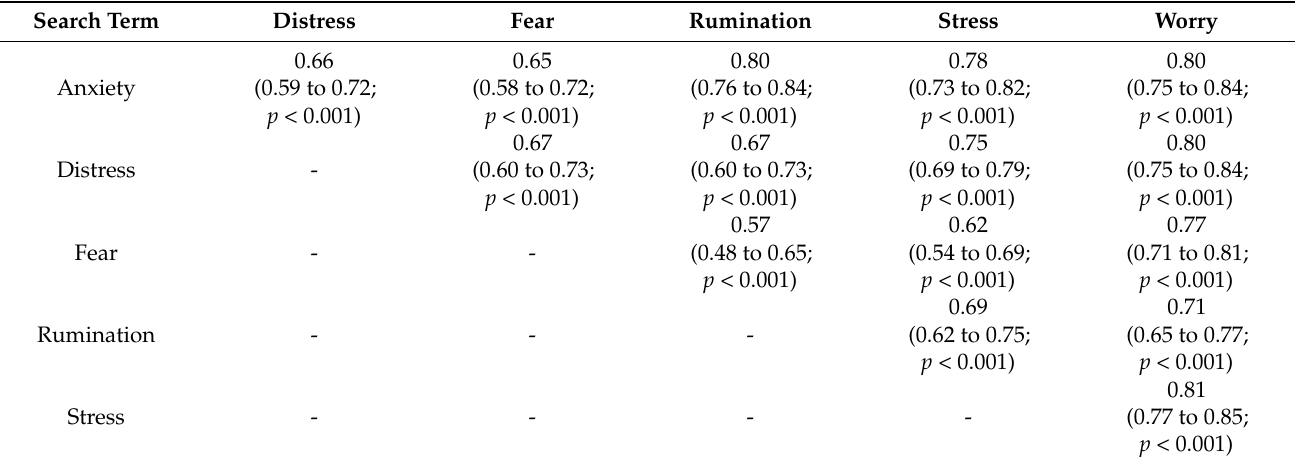
Table 1. Spearman’s correlation (and 95% confidence interval; 95%CI) between the median weekly Google Trends score of the search terms “Anxiety”, “Distress”, “Fear”, “Rumination”, “Stress” and “Worry” during the past 5 years (i.e., July 2017–July